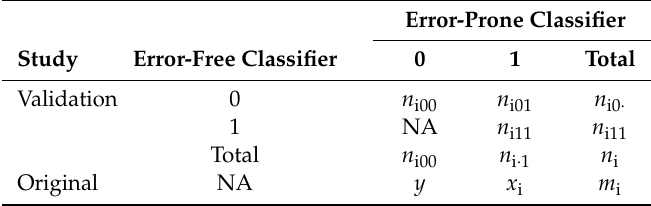
Table 1. Data for group i